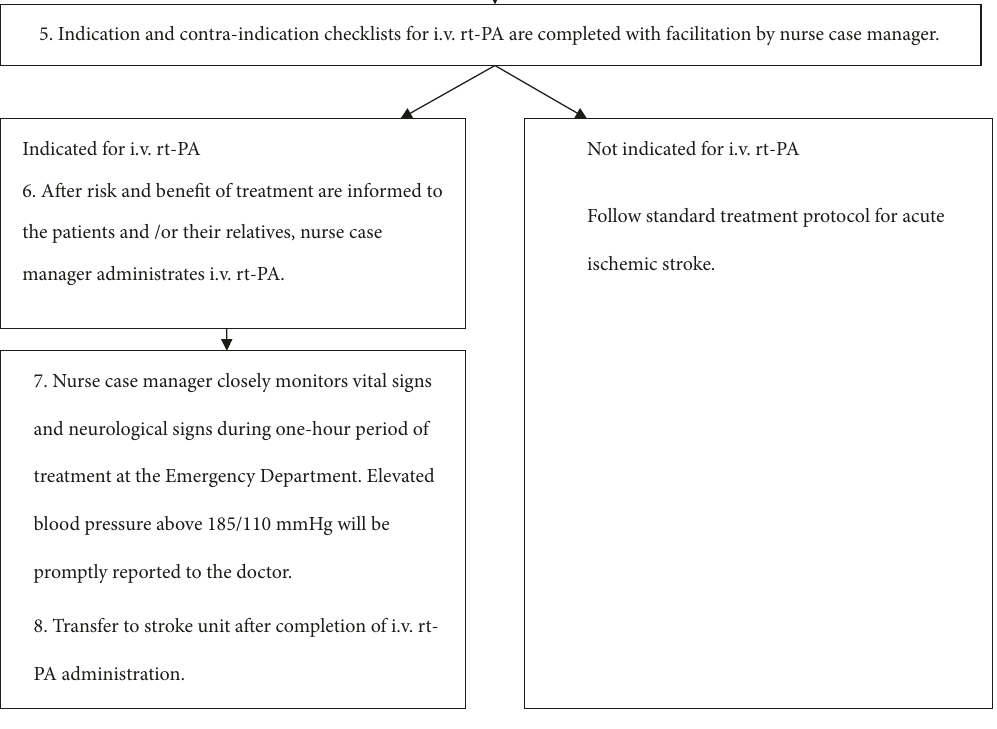
Figure 2: The schematic flow of nurse case manager for Stroke Fast